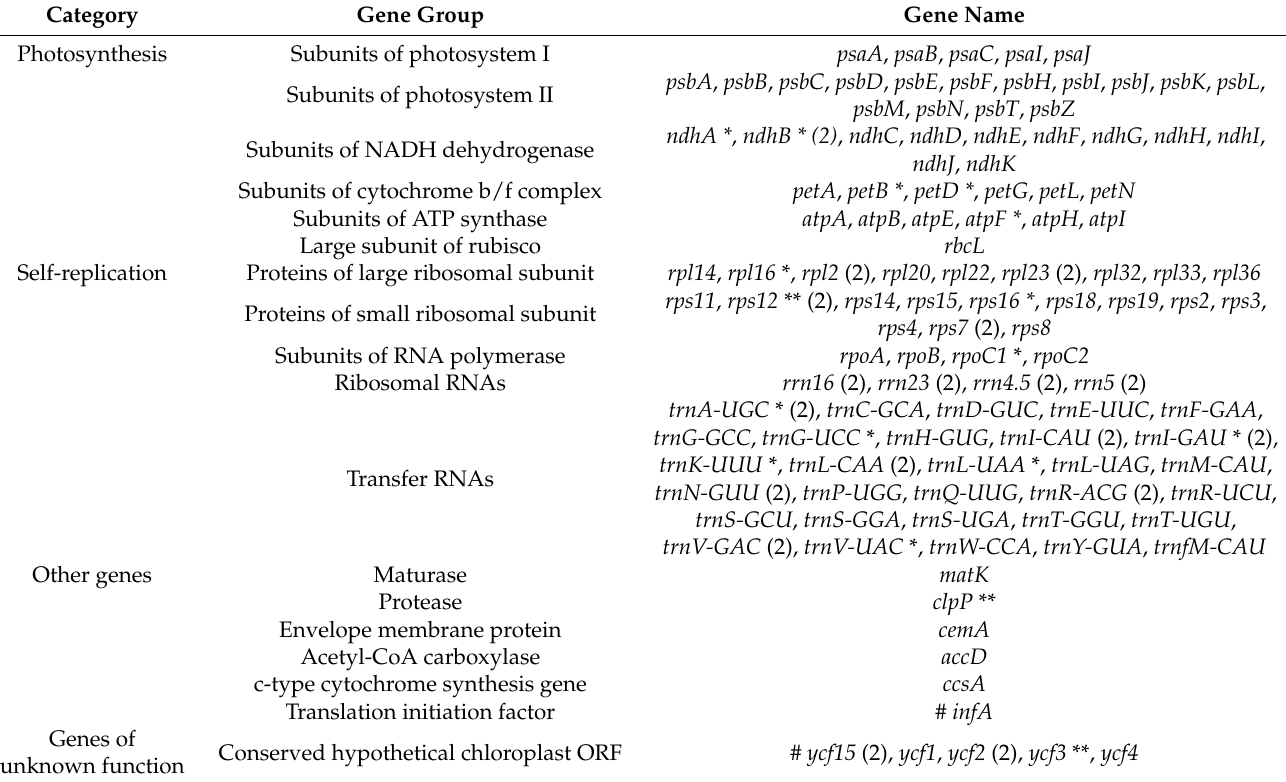
Table 2. Categorization and list of genes within wild pomegranate chloroplast genome. Category